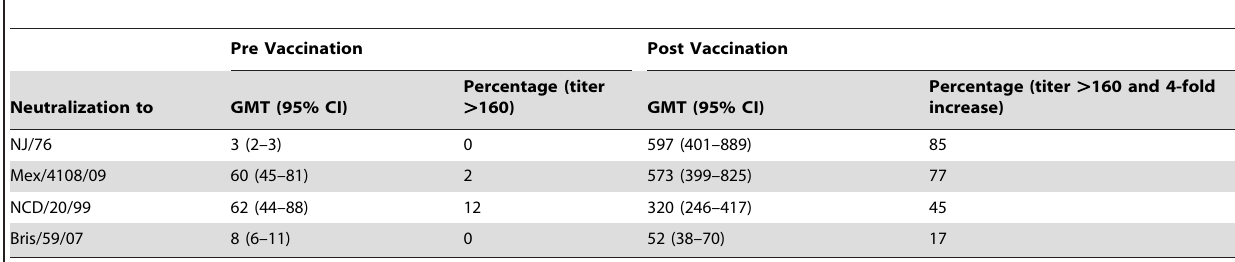
Table 1. Summary of neutralization titers of sera from the NJ/76 swine influenza vaccine